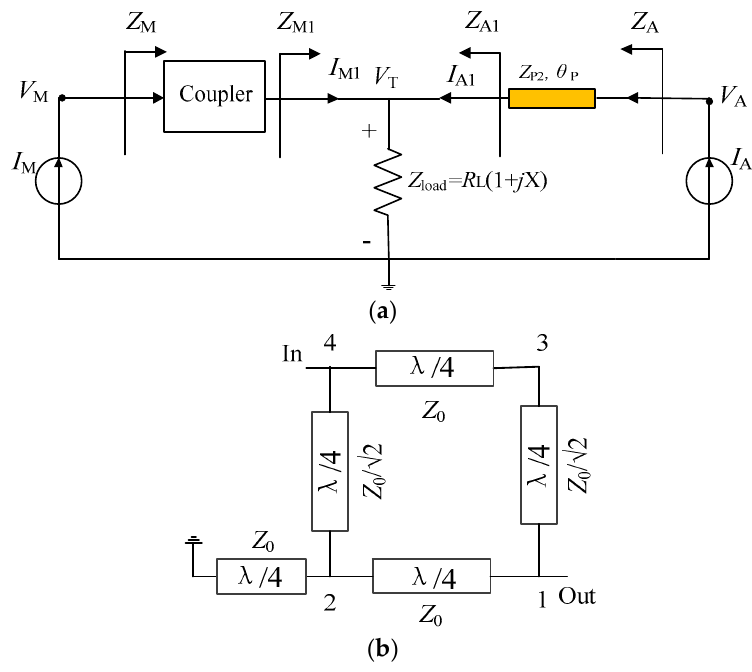
Figure 2. ( a ) Proposed DPA topology; ( b ) modified